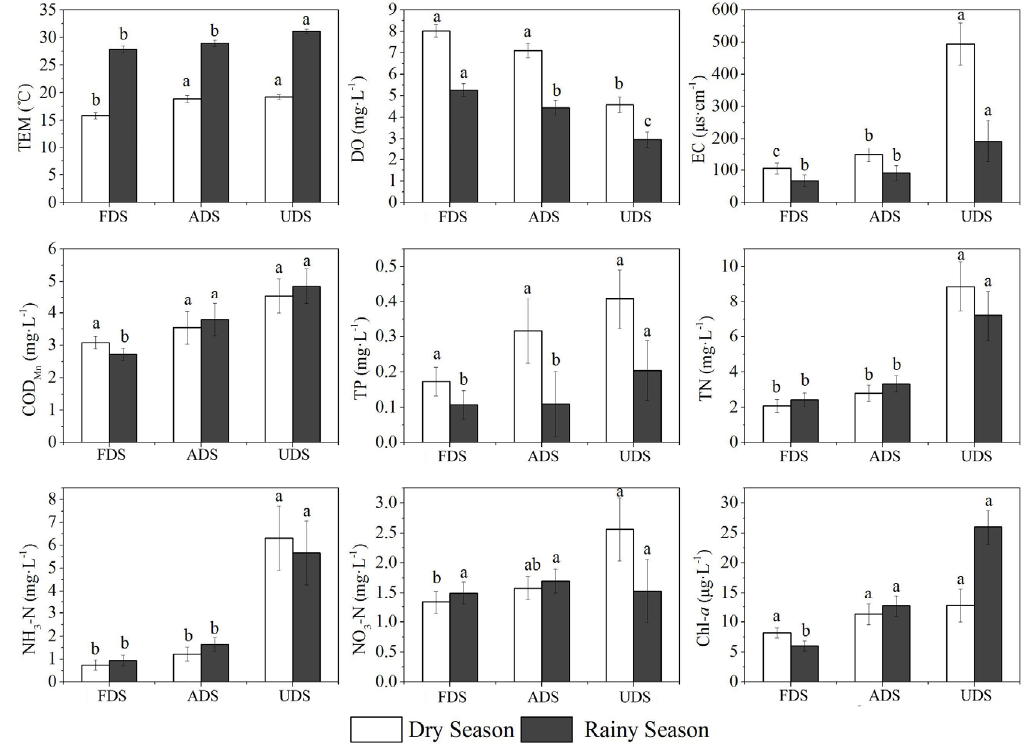
Figure 4. Mean ± standard error values for the water quality parameters among forest-dominated sites (FDS), agriculture-dominated sites (ADS) and urban-dominated sites (UDS) in the dry and rainy seasons. The variance results of the post hoc tests among the three groups are indicated by the letters, and significant differences ( p < 0.05) are indicated by different letters